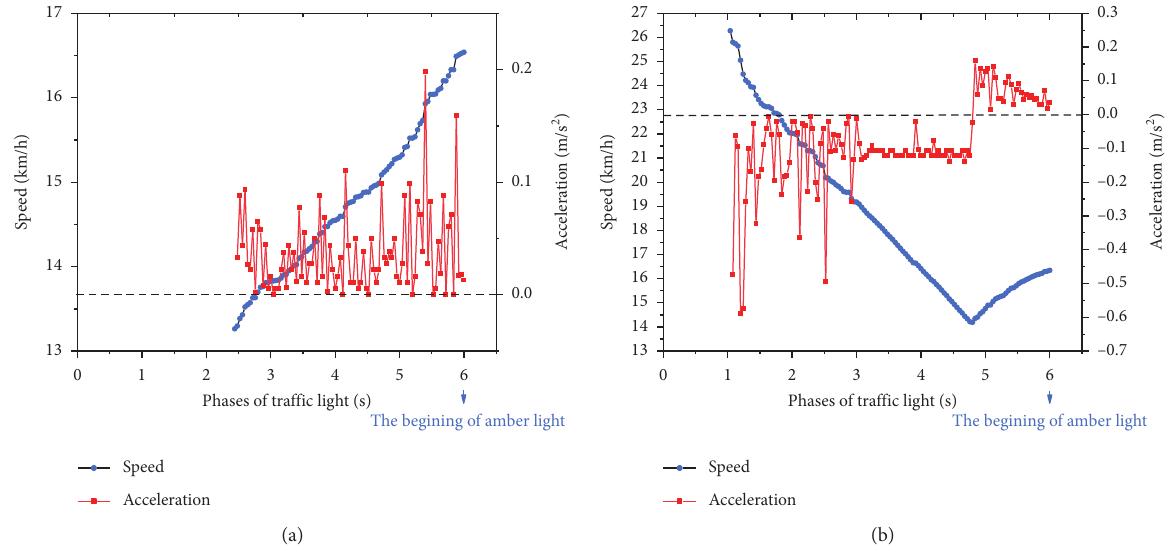
Figure 3: Typical approaching speed and acceleration rate profile of NYLR and AYLR